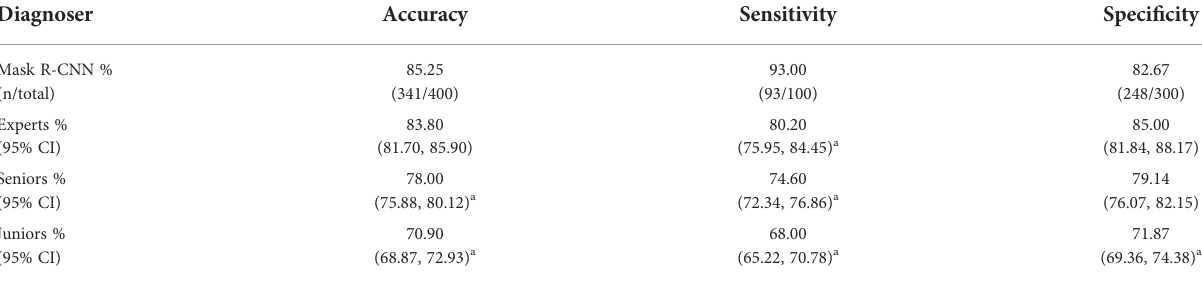
TABLE 4 Comparison between the Mask R-CNN system and endoscopists.